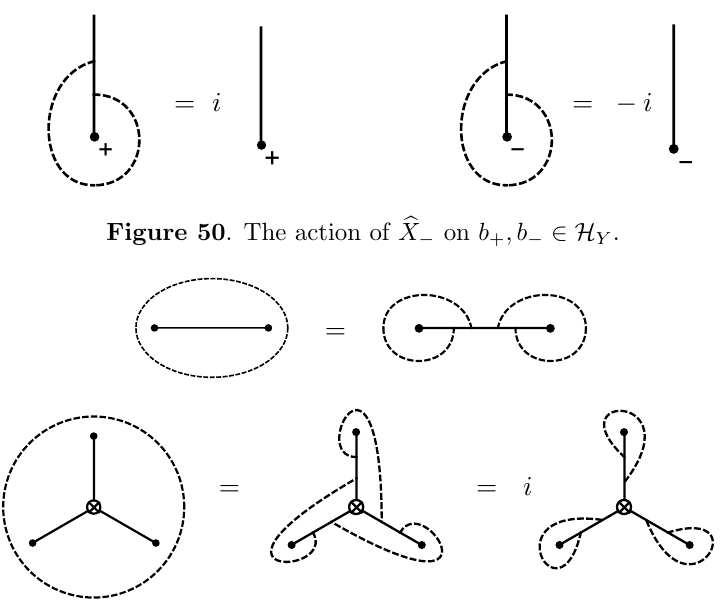
Figure 51 . The Z 2 charge ( b X value) of the OPE of a pair of defect operators b (cid:6) , as well as three defect operators joined by a Y Y Y junction, can be reduced to b X (cid:0) acting on the defect operators by a sequence of crossing relations. In the bottom row, an arbitrary Y Y Y junction vector is